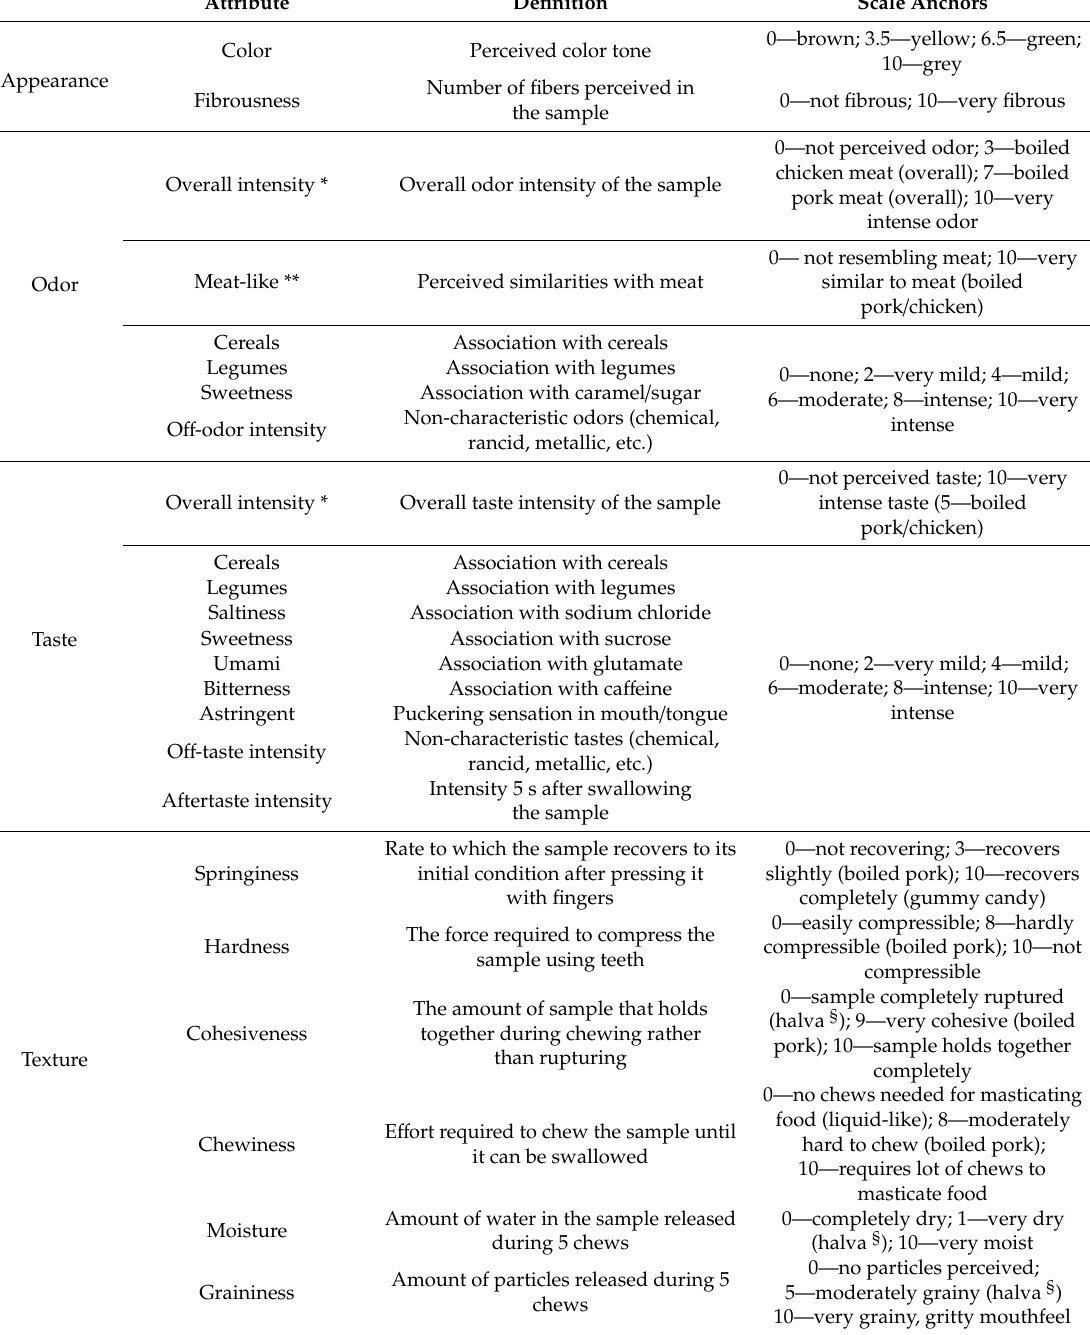
Table 2. Sensory attributes, definition, and scale anchors for meat analogues (scale